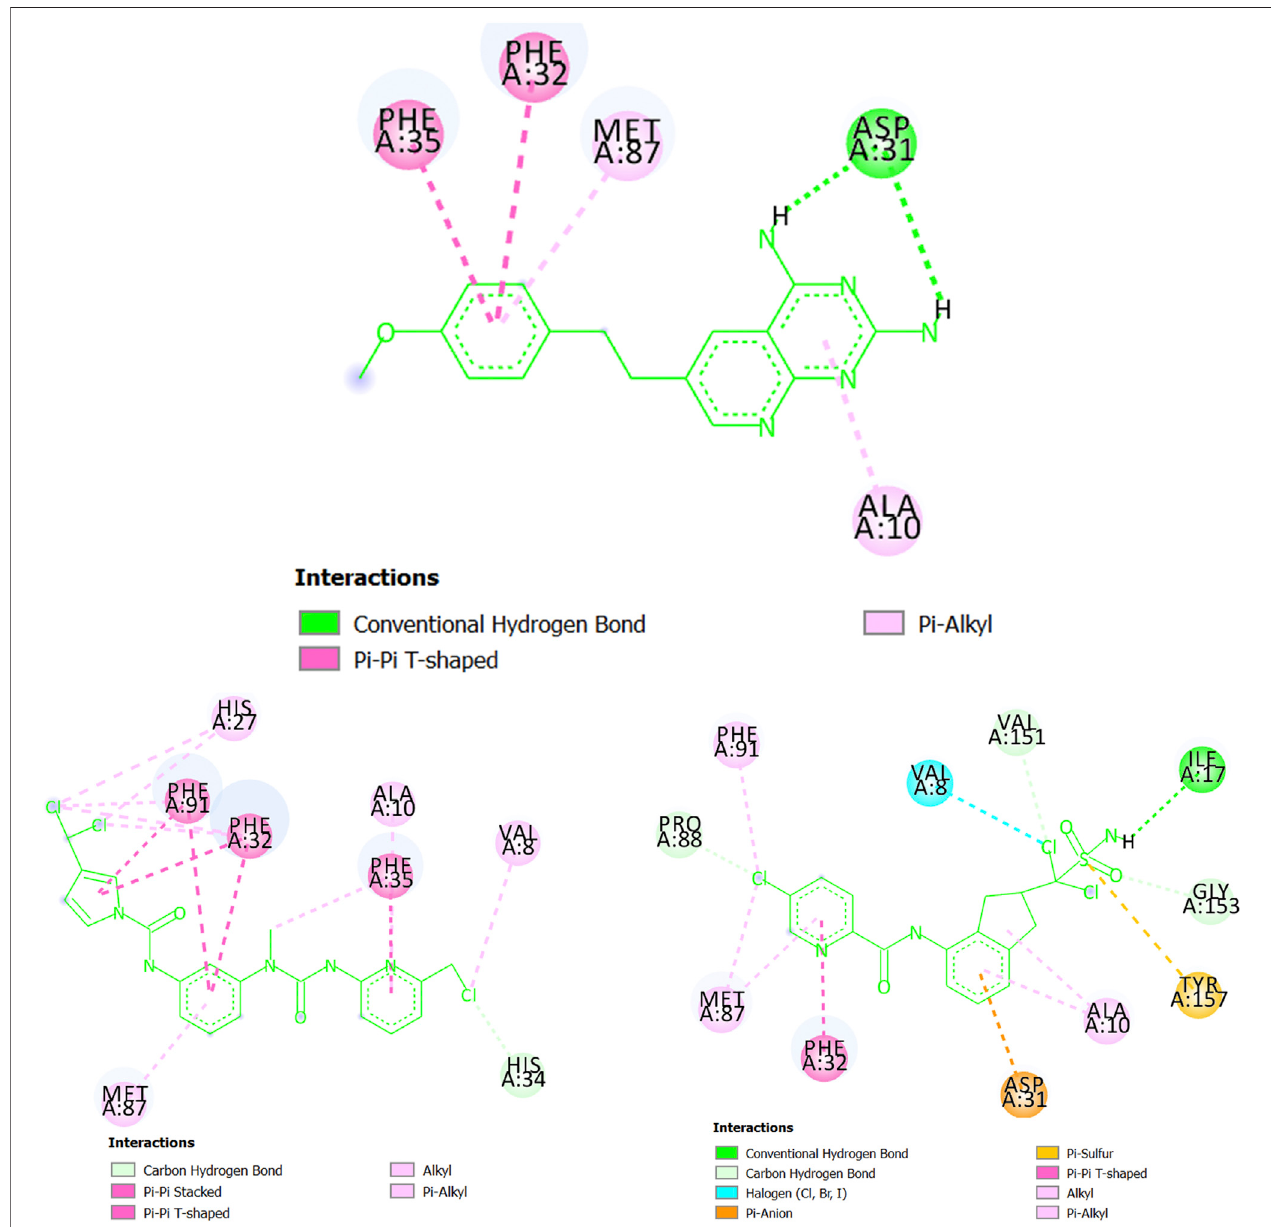
FIGURE 9 | Chemicals interactingwithdihydrofolatereductase( T.gondii ): CHEMBL145528 (topcenter) , MTIPP-002 (left bottom) and MTIPP-004 (rightbottom) .